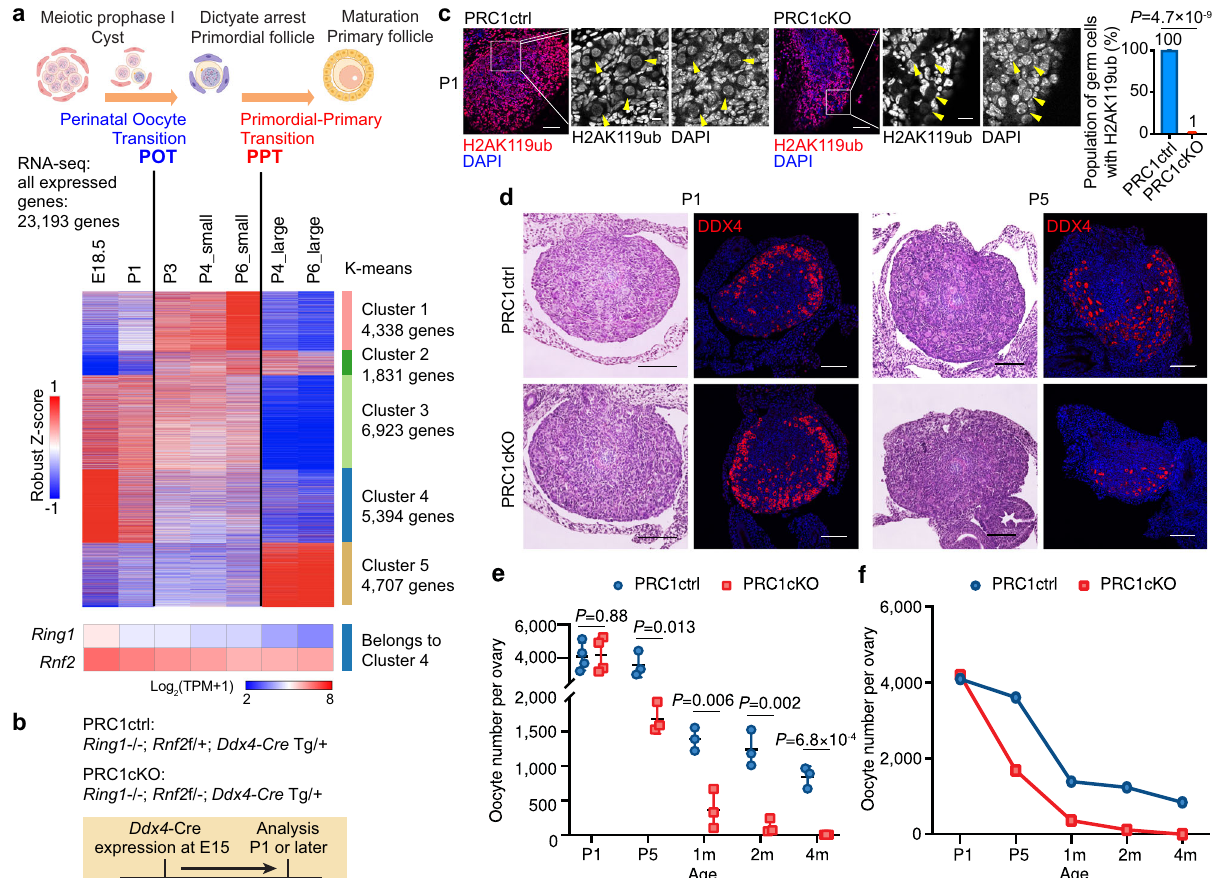
Fig. 1 PRC1 is required for ovarian reserve establishment. a Schematic of mouse perinatal oogenesis and dynamics of gene expression during Perinatal Oocyte Transition (POT). Heatmap showing gene expression during perinatal oogenesis detected by RNA-seq (Robust Z-score) and categorized into fi ve k-means clusters. All 23,193 genes expressed in at least one stage (TPM > 1) were included. In wild-type, embryonic day (E) 18.5 represents oocytes in MPI; postnatal day (P) 1 and P3 represent oocytes transitioning to dictyate arrest; P4 and P6 small oocytes represent oocytes residing in primordial follicles; and P4 and P6 large oocytes represent oocytes in primary follicles after initiation of oocyte growth. PPT, primordial-to-primary follicle transition. Expression dynamics of Ring1 and Rnf2 , which belong to Cluster 4 during perinatal oogenesis, are shown by heatmap for log 2 (TPM + 1) values separately. The illustration was created with BioRender.com. b Schematic of mouse models and experiments. c Immunostaining of H2AK119ub in ovaries of PRC1cKO and a control littermate at P1. H2AK119ub is present only in somatic cells in PRC1cKO. Bars: 50 μ m (10 μ m in the boxed area). PRC1cKO exhibited a nearly complete loss (99%) of H2AK119ub at P1, con fi rming the highly ef fi cient deletion of Rnf2 by Ddx4 -Cre. Data are presented as mean values ± SD. Two-tailed unpaired Student ’ s t-tests. Three independent biological replicates were analyzed for each genotype. d Ovarian sections of PRC1ctrl and PRC1cKO mice at P1 and P5, respectively. The sections were stained with hematoxylin & eosin or immunostained for DDX4 (red). Bars: 100 μ m. At least three mice were analyzed for each genotype at each time point, and representative images are shown. e Estimated numbers of oocytes per ovary from PRC1ctrl and PRC1cKO mice at P1, P5, 1 month, 2 months, and 4 months. At least three mice were analyzed for each genotype at each time point. Black bars represent mean values. Two-tailed unpaired Student ’ s t-test. f Dynamics of oocyte number between P1 and 4 months of age in PRC1ctrl and PRC1cKO females. Source data are provided as a Source Data fi